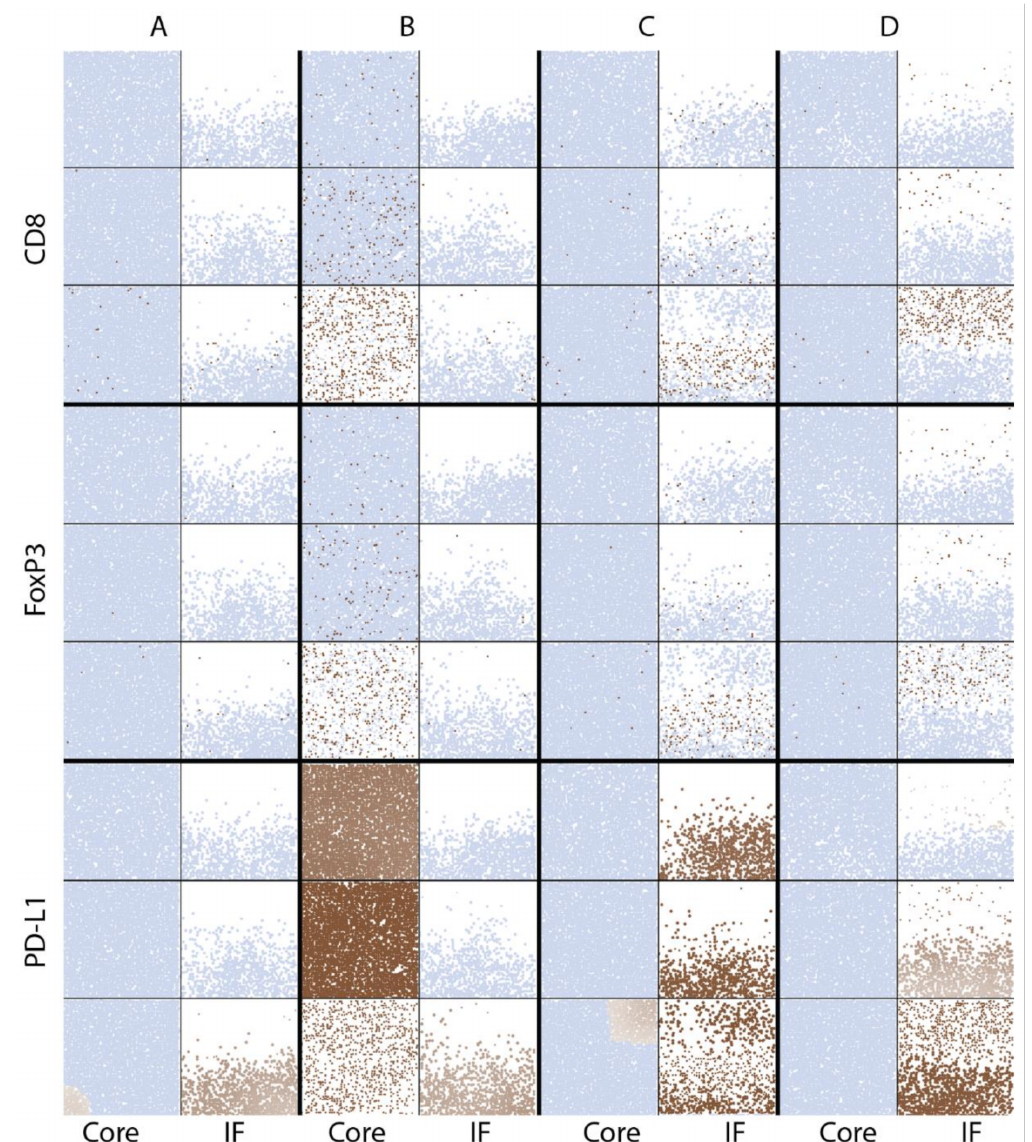
Figure 7. Virtual IHC of pretreatment CD8+, FoxP3+ and PD-L1+ distribution from core and invasive front ROIs of simulated tumor. Light blue: nuclei, indicating location of nucleated cells; brown: indicated labels of CD8, FoxP3 or PD-L1, with the darkness representing their intensities. Time points chosen are pretreatment, early treatment and day 200. ( A ) Baseline vascular densities. ( B ) Increased vascular density in the tumor core. ( C ) Increased vascular density in tumor at the invasive front. ( D ) Increased vascular density in normal tissue outside of the invasive